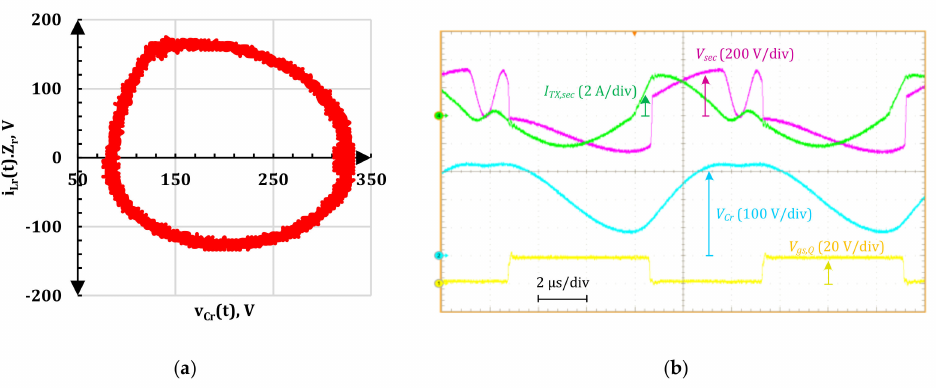
Figure 18. Experimental waveform of the proposed converter for scenario A: ( a ) Trajectory curve and ( b ) steady-state